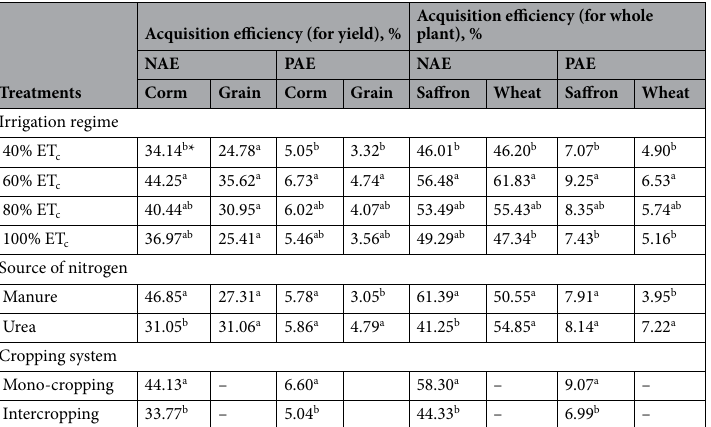
way of partitioning between nitrogen or phosphorus uptake by grain and straw and NHI or PHI values allow for convenient prediction of straw nitrogen or phosphorus as grain nitrogen or phosphorus data are readily available. Nutrient acquisition (uptake) efficiency. in yield and in the whole plant (Table S13 and Table 9) which indicates the highest uptake efficiencies for P and N minerals. Furthermore, there was no significant difference between sources of nitrogen on NAE for grain and wheat plant and on PAE for corm and saffron plant. However, manure increased 51.0% and 49.0% nitrogen uptake efficiencies for corm and saffron plant, respectively, while for PAE of the grain and the whole wheat plant, the trend was opposite and urea fertilizer increased phosphorus uptake efficiency in wheat grain and in the whole wheat plant compared to animal manure. This is due to lower total available phosphorus in the urea treatment. In general, intercropping decreased yield and plant nutrient (P and N) uptake efficiencies in contrast to sole saffron due to the nutrient competition of wheat plant. Nutrient utilization efficiency.